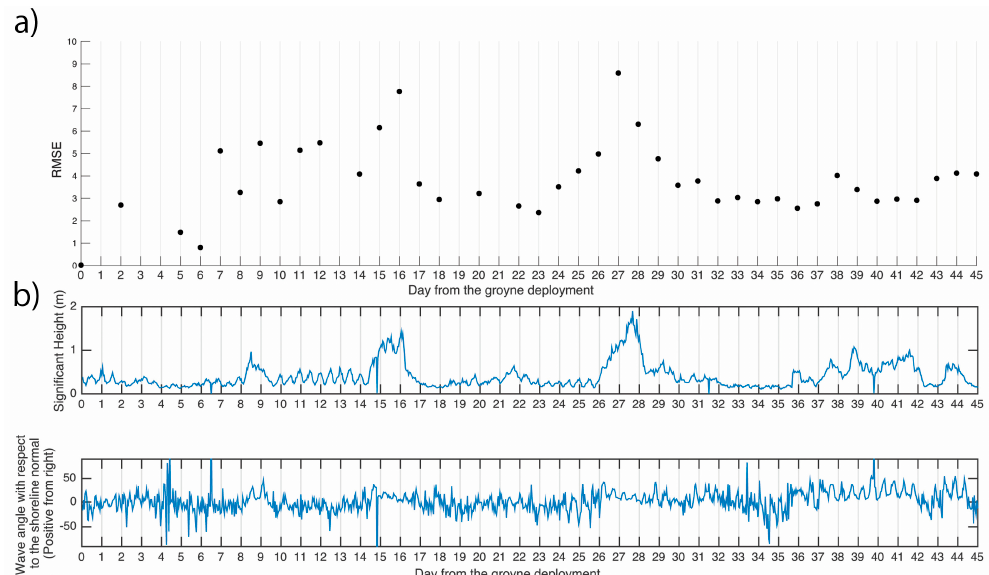
Figure 15. ( a ) Estimated RMSE daily values. ( b ) Time history of significant wave height and wave angle.